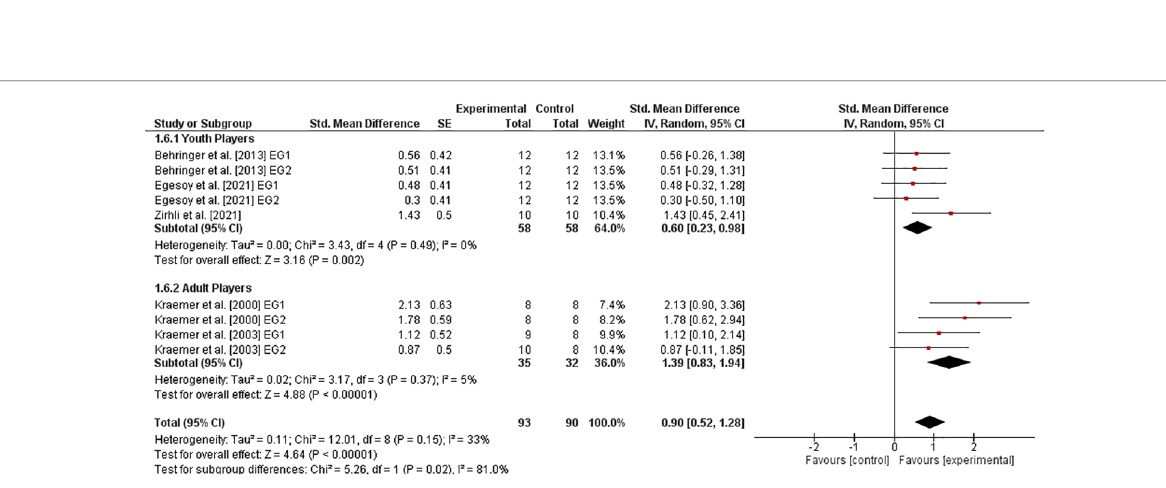
FIGURE 6 Effects of athletic training on measures of upper-extremity muscle strength (e.g., handgrip strength) in healthy youth and adult tennis players. CI = con fi dence interval, df =degrees of freedom, SE =standard error, IV =inverse